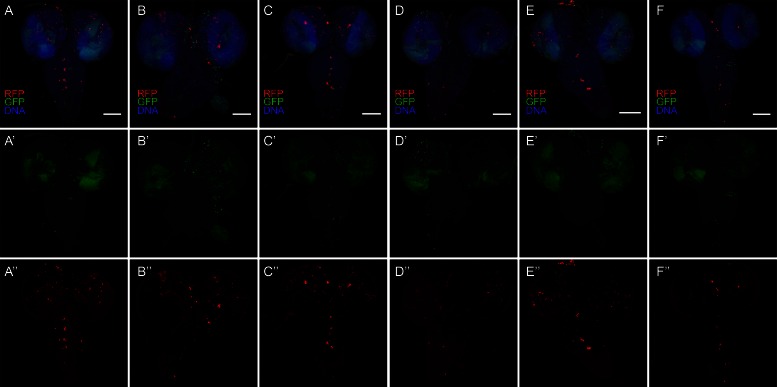
Diverse CasExpress activation patterns in larval CNS.(A–F) Six different examples of RFP (red) and GFP (green) CNS expression patterns in late 3rd instar larvae. DAPI is shown in blue. (A’–F’) GFP only. (A”–F”) RFP only. All scale bars are 100 μm. Note that patterns differ from animal to animal and are not bilaterally symmetric.